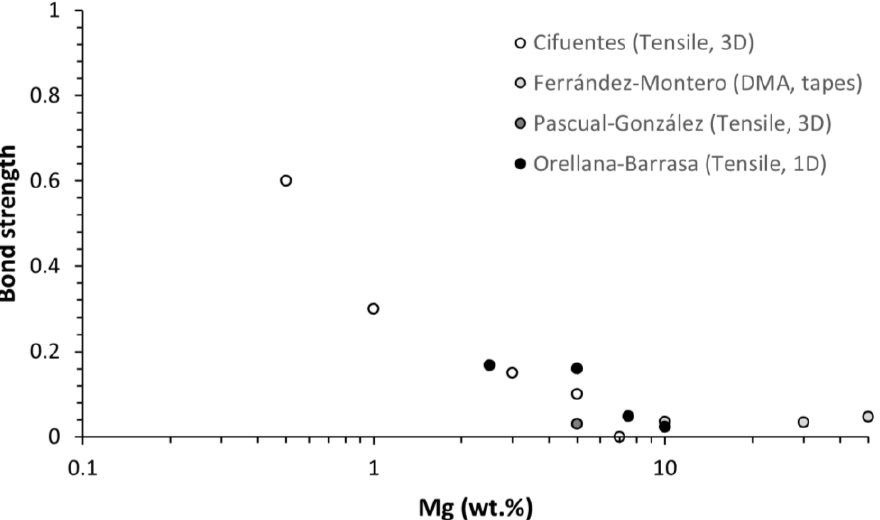
Figure 11. Lower limit values of PLA-Mg bond strengths calculated from the Voigt model. Data derived from Cifuentes [27], Ferrández-Montero [23], Pascual-González [22], and Orellana-Barrasa.